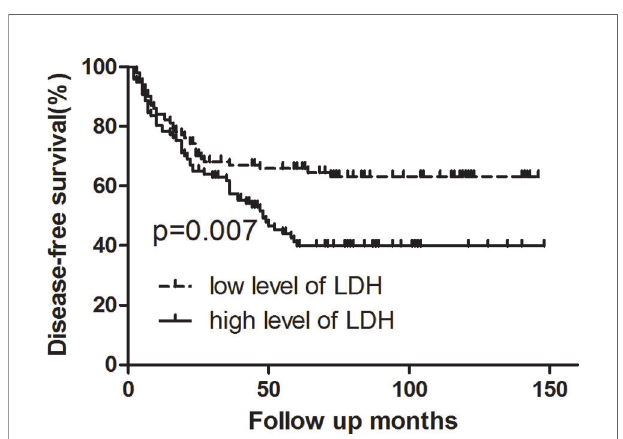
FIGURE 2 | Kaplan – Meier curve for disease-free survival, strati fi ed by pretreatment serum LDH ≤ 178 U/L and >178U/L. Log-rank test, P